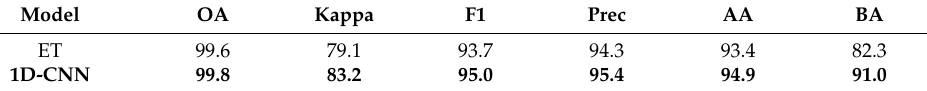
Table 7. Classification metrics of ET, the 1D-CNN, and the NBR for comparison on the unknown selected Spanish regional dataset in%. The bold value represents the best classification results.